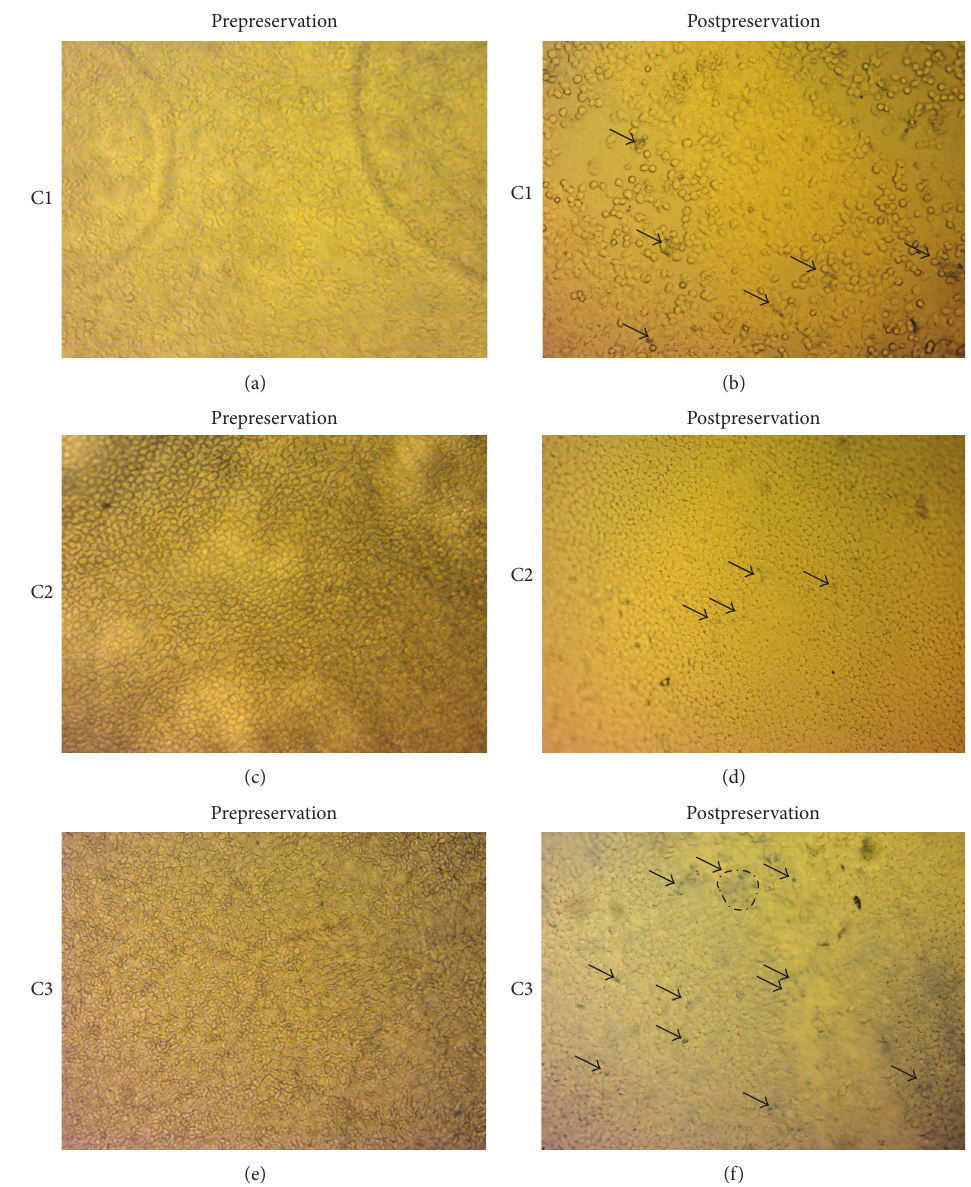
Figure 1: Endothelial cell density, mortality, and uncovered areas of preloaded DMEK lenticules at 100 magnification. (a, c, e) show healthy endothelium that was found after stripping with minimal mortality in different conditions as listed. (b, d, f) show mortality and uncovered areas in each condition. C1 and C3 showed high mortality (trypan blue positive cells marked with arrow) and uncovered areas as compared to C2, which showed minimal